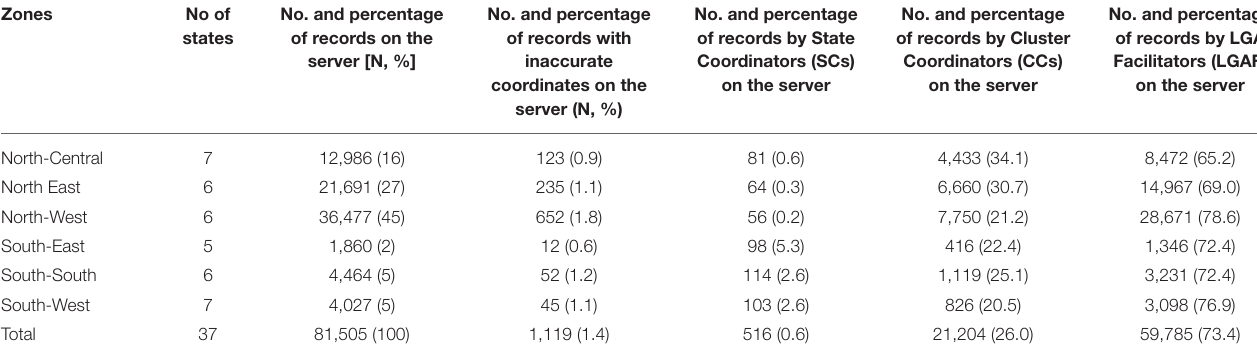
TABLE 1 | Number of records and those with inaccurate coordinates by political zone and cadre of personnel.